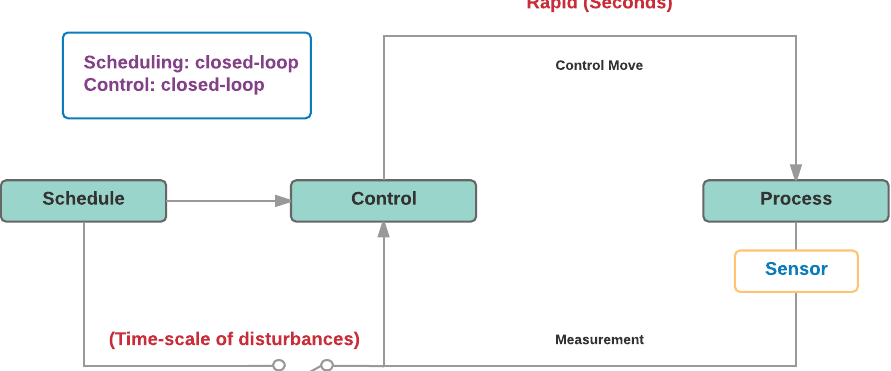
Figure 2. Phase 2: Dual-loop segregated scheduling and control. Scheduling is recalculated reactively in the presence of process disturbances above a threshold or updated market conditions. Closed-loop control implements the schedule in the absence of